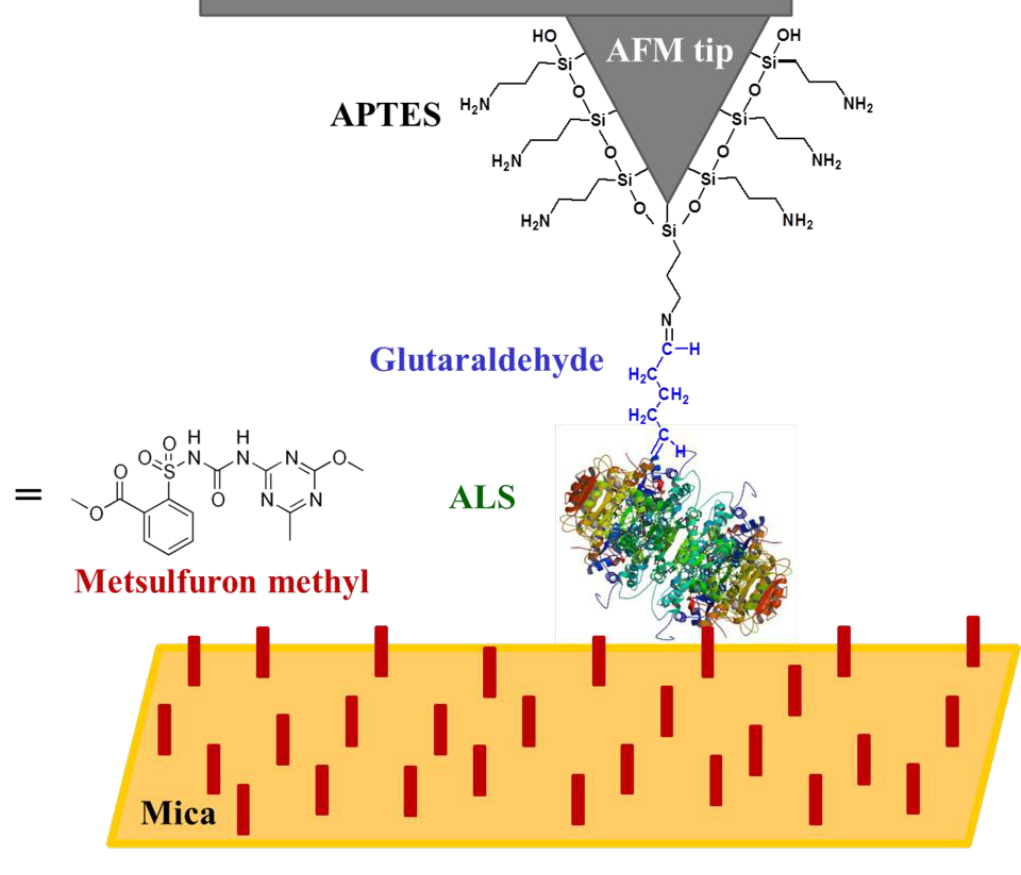
Figure 3. Schematic illustrating the functionalisation of the silicon nitride tip and the detection of metsulfuron-methyl herbicide on the mica